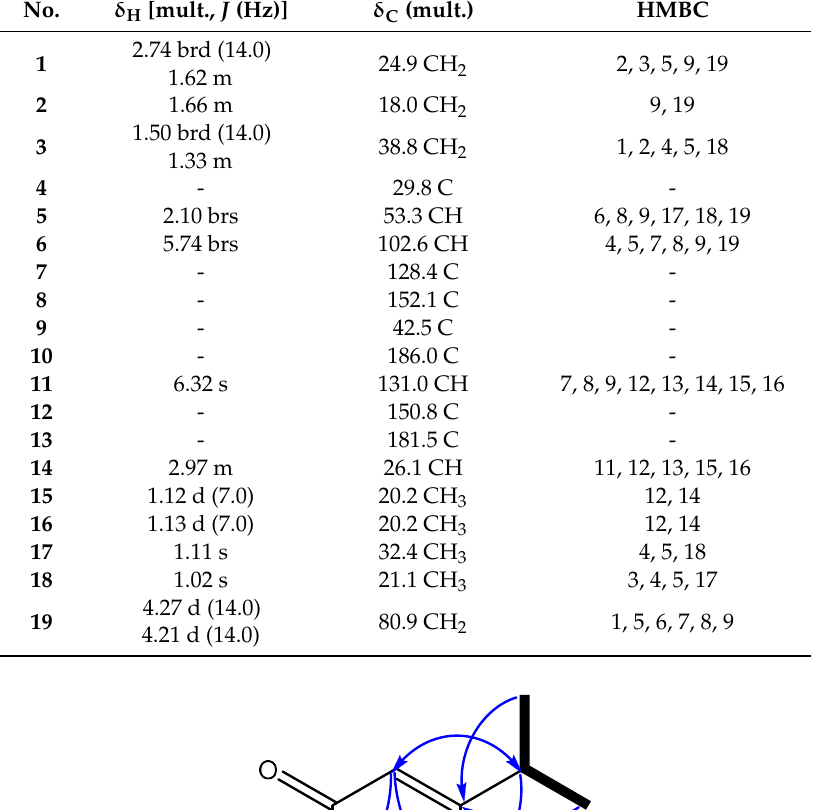
Table 1. NMR spectral data of compound 2 (CD 3 OD, 700, and 176 MHz).